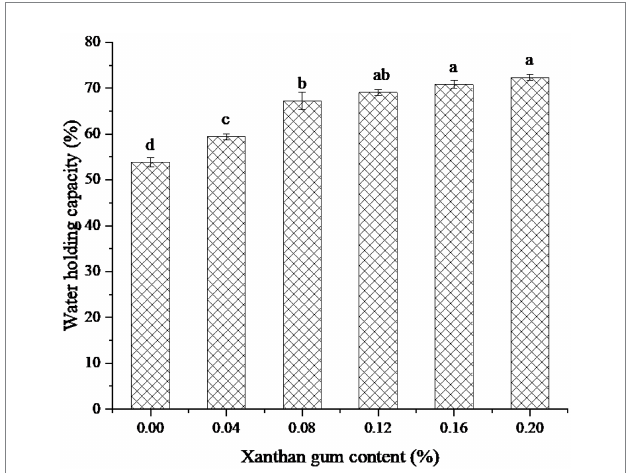
FIGURE 5 The water holding capacity of protein powder gel for xanthan gum addition. Different lowercase letters express the significant differences ( p <